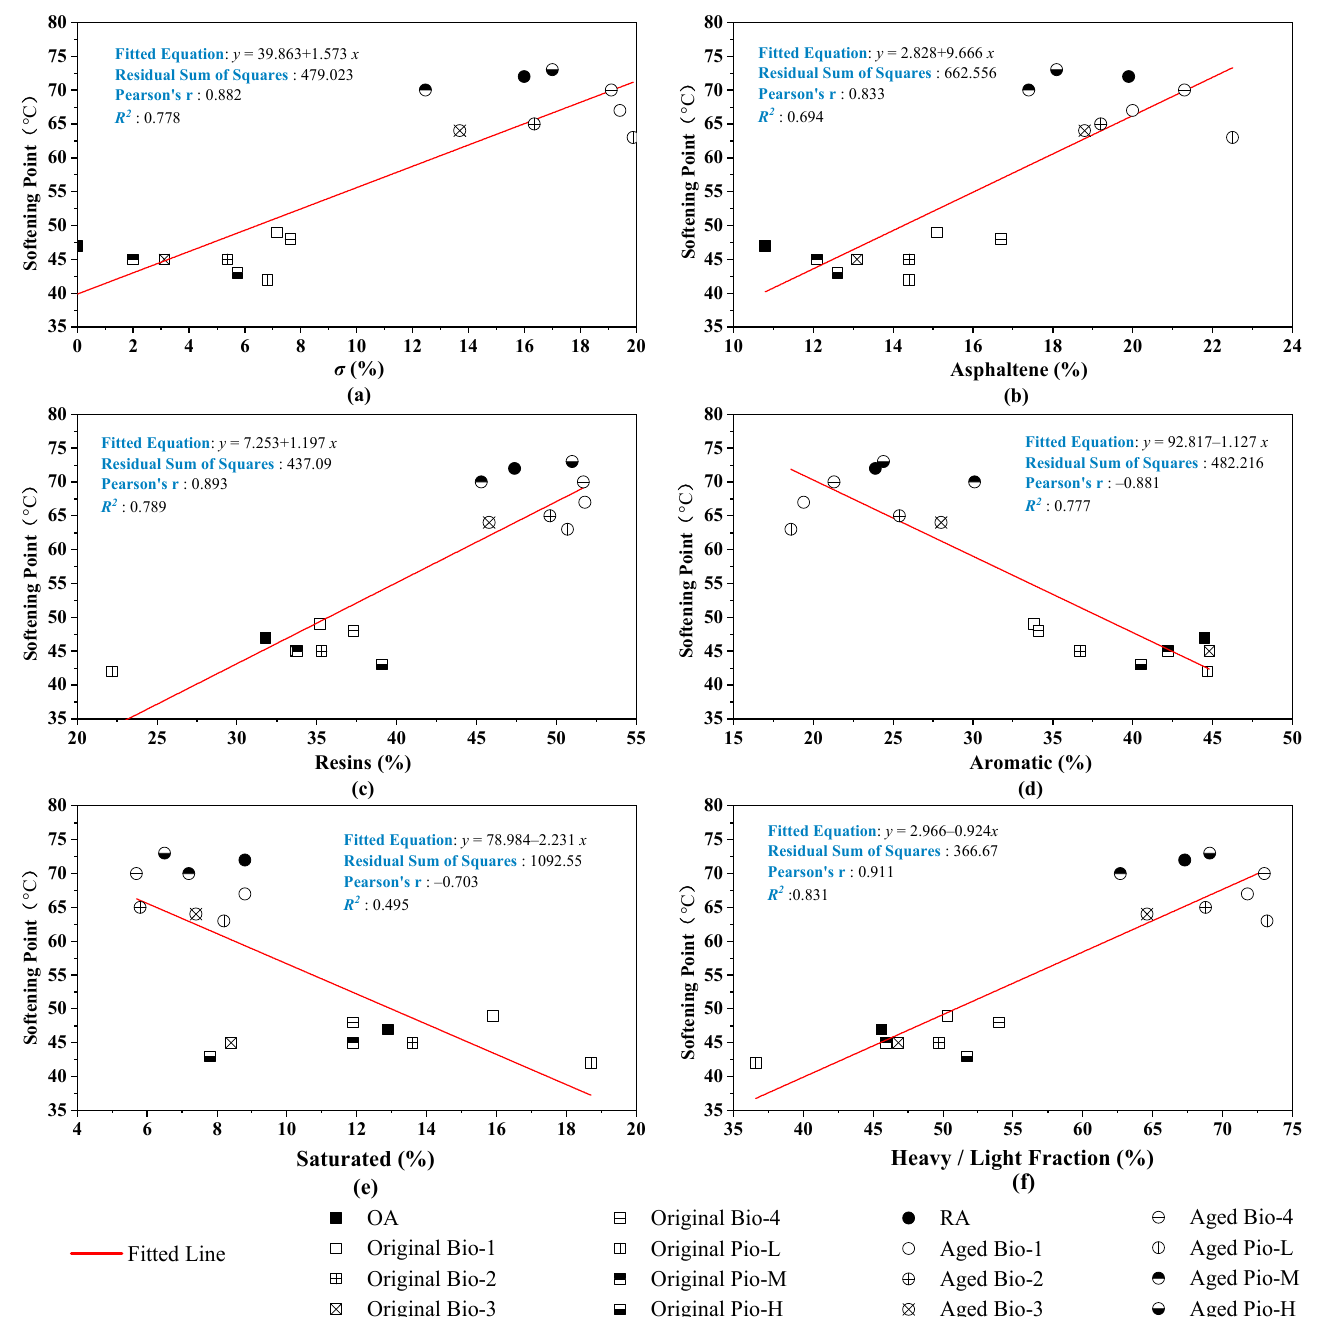
Figure 17. Correlation analysis between the softening point and fraction indicators. ( a ) σ ; ( b ) as- phaltene; ( c )resins; ( d ) aromatic; ( e ) saturated; ( f ) heavy/light.